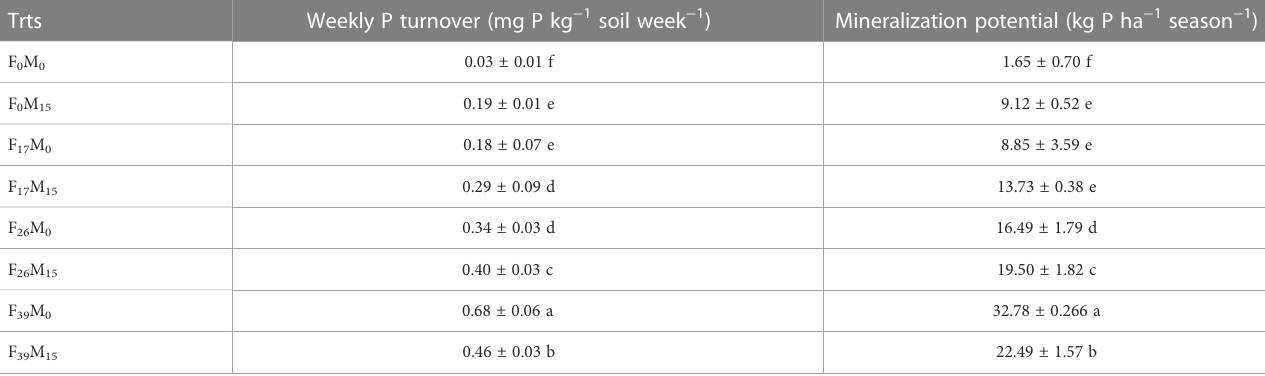
TABLE 3 Laboratory incubation: effect of fertilizer phosphorus (P) and farmyard manure (FYM) application on weekly turnover P and mineralization potential.